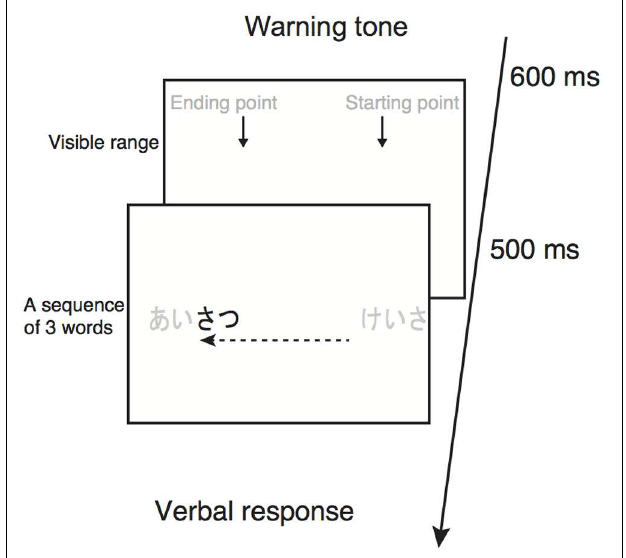
FIGURE 1 | Schematic illustration of experimental procedure in Experiments 1 and 2. Gray-colored characters are not visible during the experiments. The arrows in the upper panel indicate the starting and ending points of scrolling text. The dotted arrow indicates the direction of scrolling.